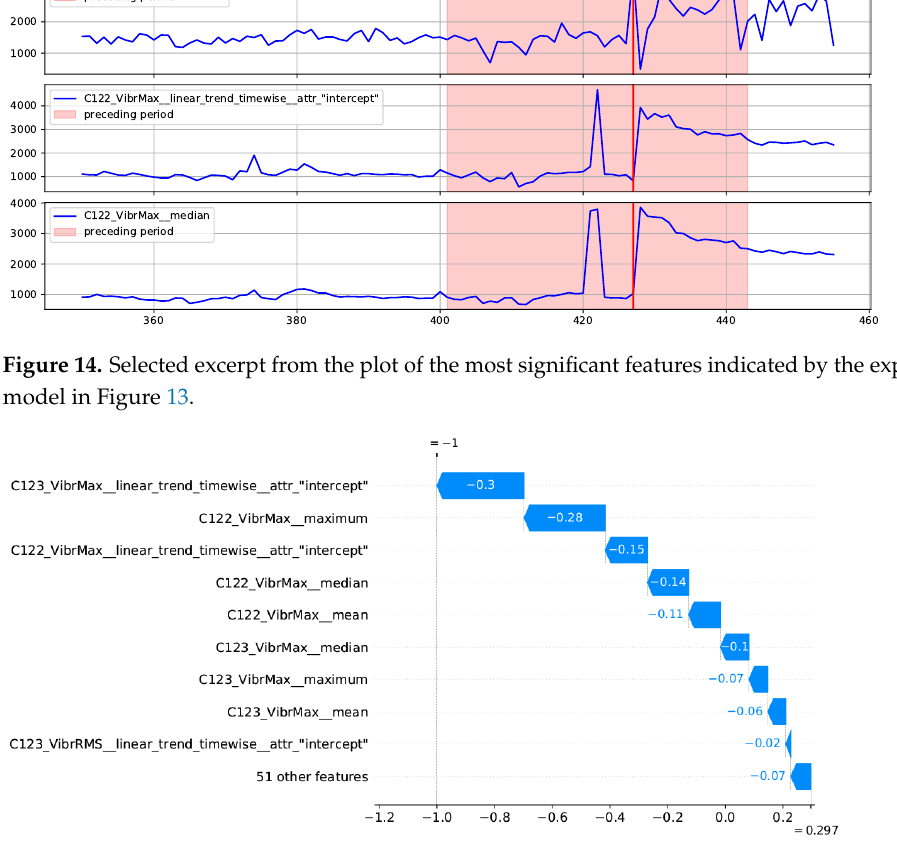
Figure 15. Waterfall plot of SHAP explanations for individual prediction (false positive case)—the explanation applies to the location marked by the red straight line in Figure